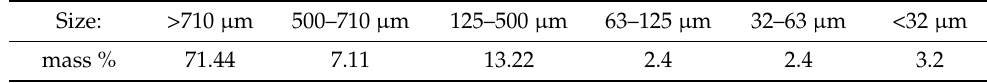
Table 2. Particle size distribution of “as-received”